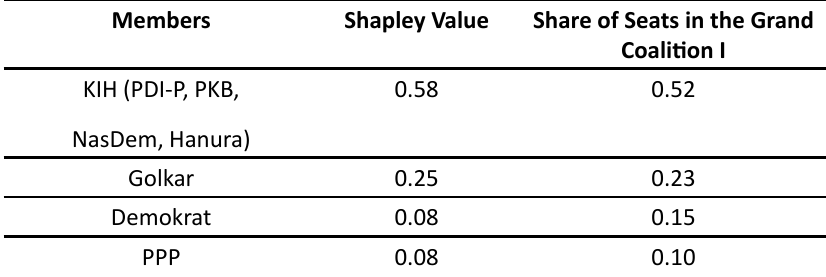
Table 3: Shapley Value and Seats in Parliament of the Grand Coalition Members Shapley Value Share of Seats in the Grand Coalition